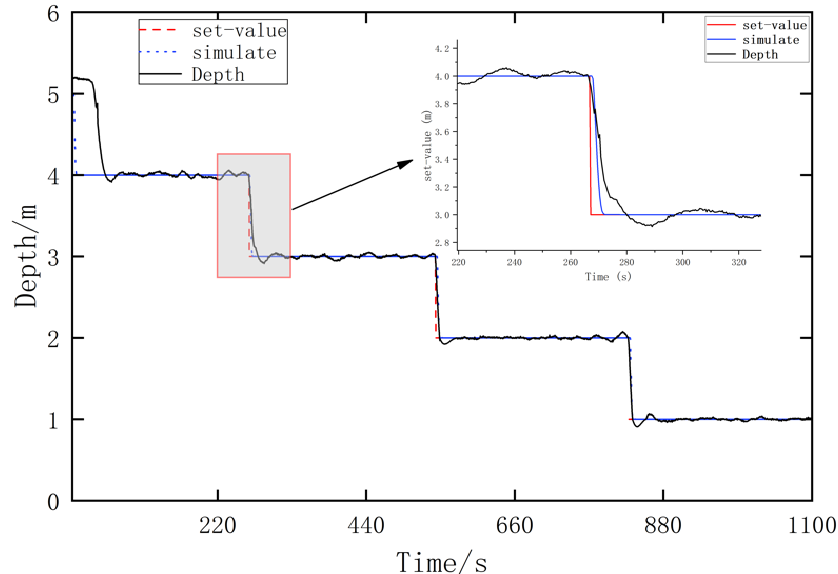
Figure 18. Depth control result in hovering mode.